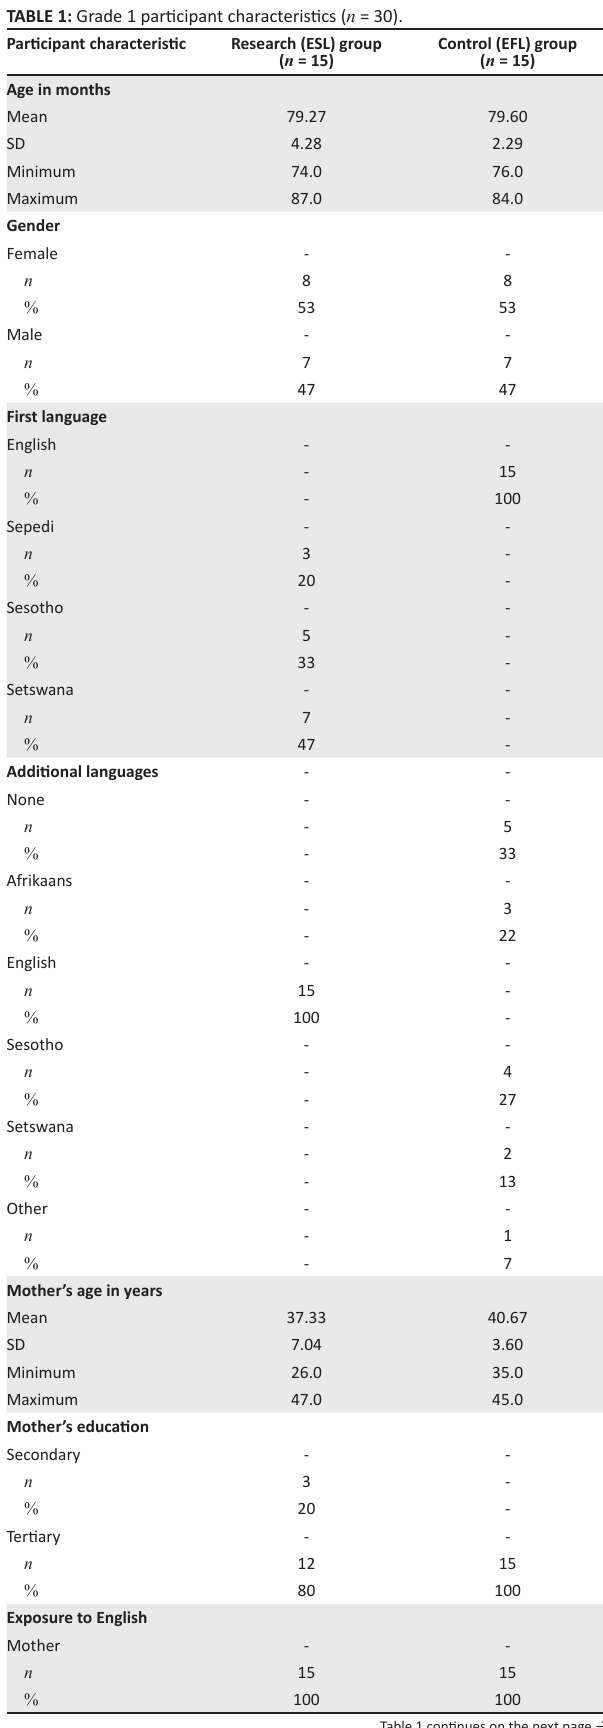
TABLE 1: Grade 1 participant characteristics ( n =